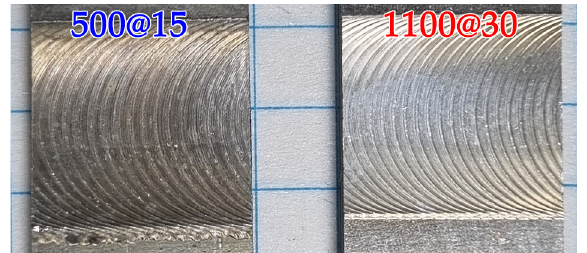
Figure 2. Macroscopic photograph of the dissimilar FSW joints.